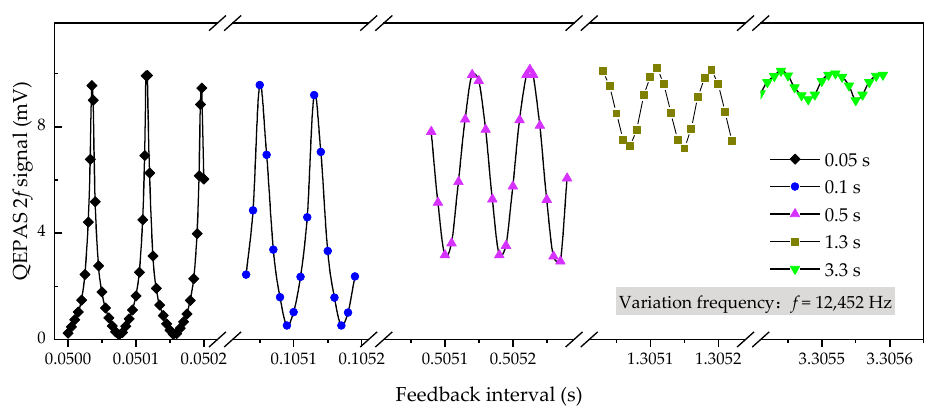
Figure 4. QEPAS response curves to feedback intervals around 0.05 s, 0.1 s, 0.5 s, 1.3 s, and 3.3 s respectively. The experiment was performed with 1000-ppm CO 2 enclosed inside the ADM.